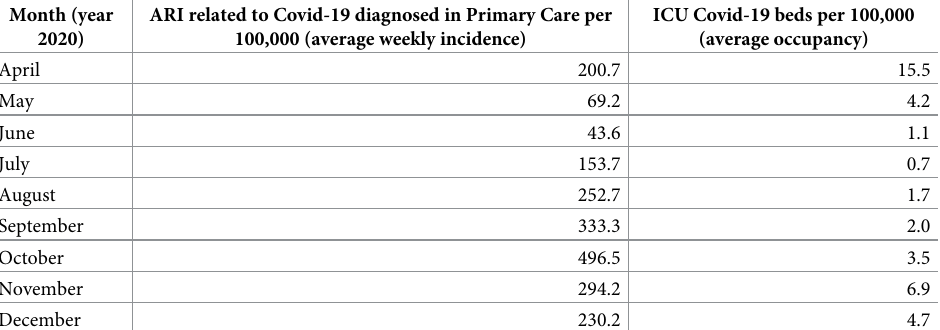
Table 1. Average weekly incidence of Acute Respiratory Infection (ARI) cases with Codid-19 diagnosed in Pri- mary Care and Average Intensive Care Unit (ICU) Bed Occupancy of Covid-19 patients, all per 100,000 habitants by months in Catalonia, Spain.